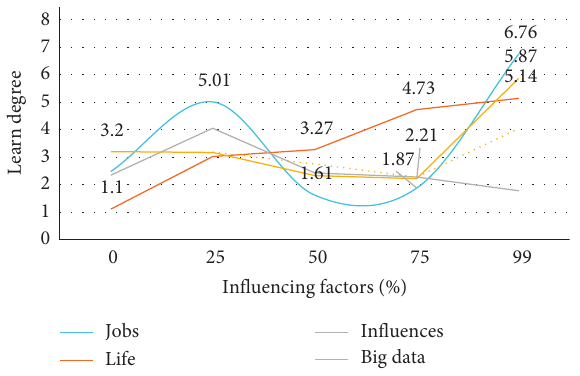
Figure 4: Employees’ views on big data. Table 6: The reality is that big data has penetrated into life and work.